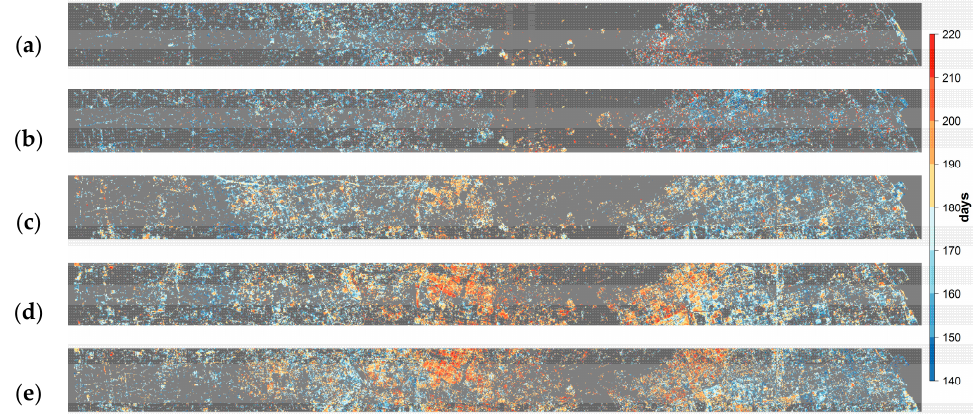
Figure 6. Spatial pattern of the mean LOS for urban vegetation along the east-west transect for the five periods: ( a ) 1984–1995; ( b ) 1996–2000; ( c ) 2001–2005; ( d ) 2006–2010 and ( e ) 2011–2015.